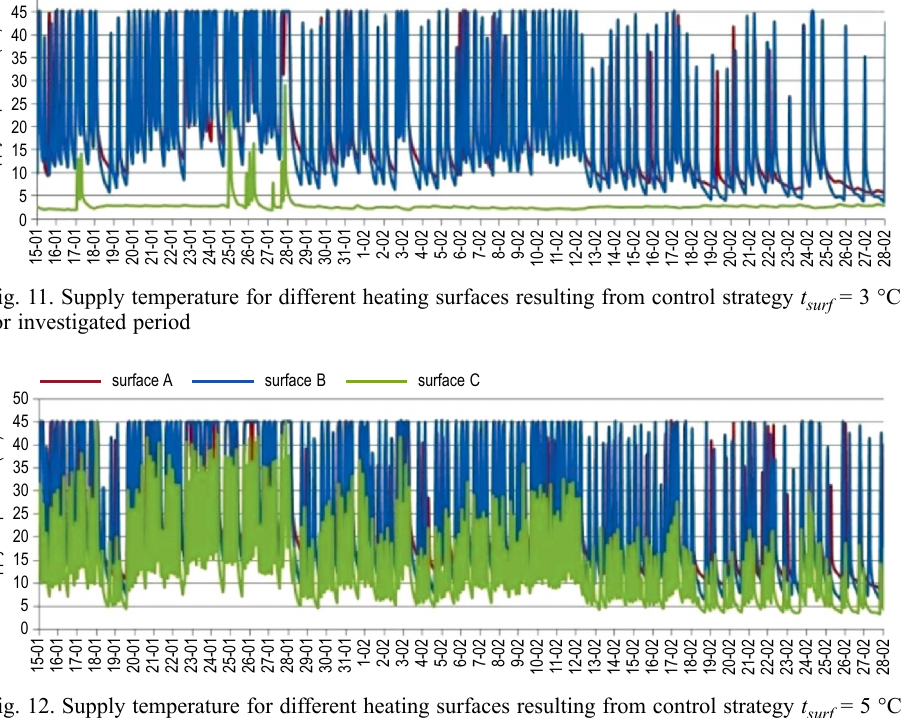
Fig. 12. Supply temperature for different heating surfaces resulting from control strategy t surf = 5 °C for investigated period